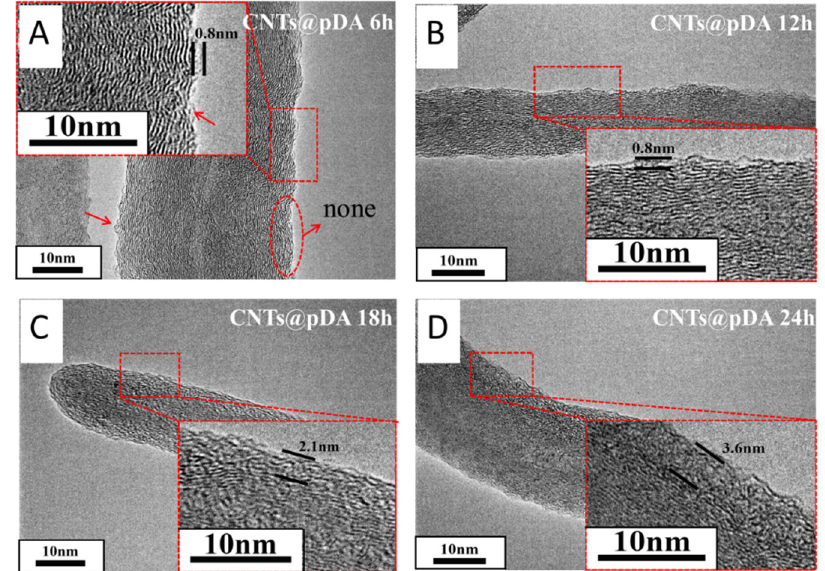
Figure 2. High resolution transmission electron microscope (HRTEM) image of CNTs@pDA at different modification times (6, 12, 18, and 24 h, respectively). ( A ) The image of CNTs@pDA modified over 6 h. The wall of the CNTs was partially modified by pDA. The enlargement image showed that the thickness of the deposited pDA was 0.8 nm. ( B ) The image of CNTs@pDA modified over 12 h. The wall of the CNTs was completely modified. The thickness of the deposited pDA was still 0.8 nm. ( C ) The image of CNTs@pDA modified over 12 h. The pDA thickness increased to 2.1 nm. ( D ) The image of CNTs@pDA modified over 24 h. The thickness of the pDA was 3.6 nm. The scale bar was 10 nm.